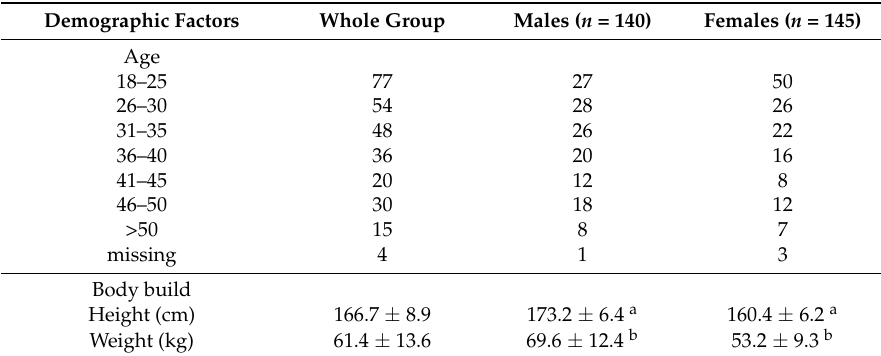
Table 1. Demographic profile of participants ( n =